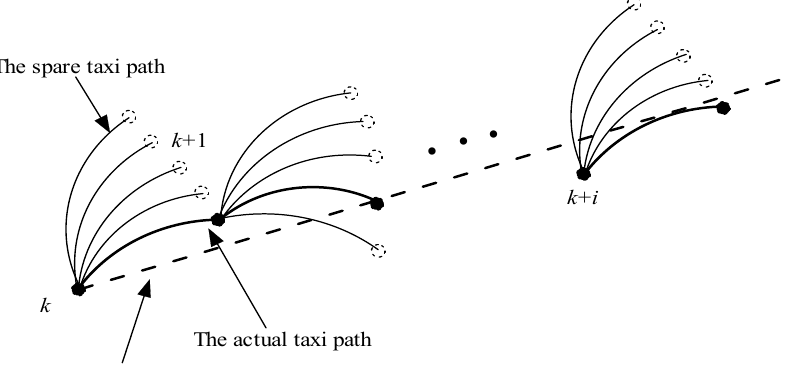
Figure 4. Diagram of discretizing the controlled variables.